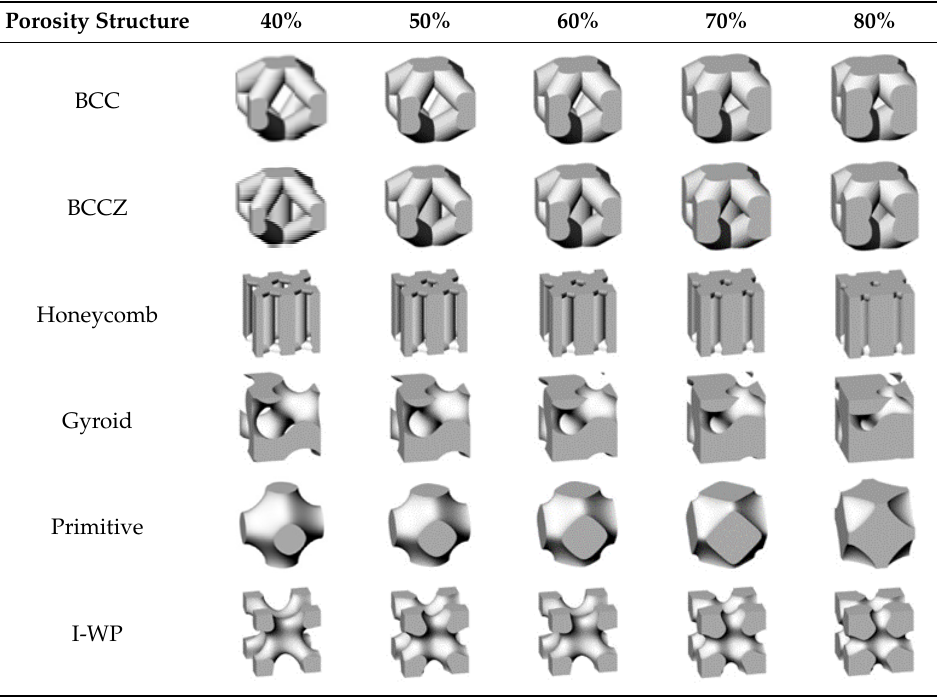
Table 1. Body-centered cubic (BCC), BCC with Z-struts (BCCZ), honeycomb, gyroid, primitive, and I-WP unit cells with 40–80% relative density.